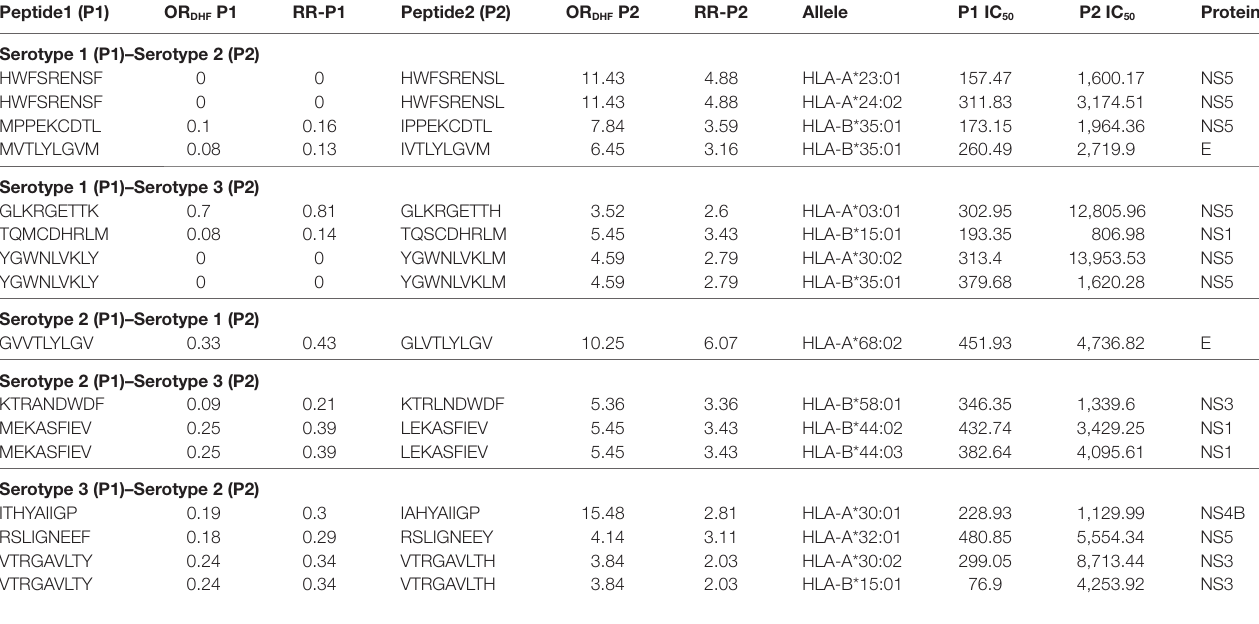
TaBle 4 | HLA-I binding single amino acid variants present differentially in dengue fever and dengue hemorrhagic fever (DHF) having primary and secondary infection with different serotypes. Peptide1 (P1) Or DhF P1